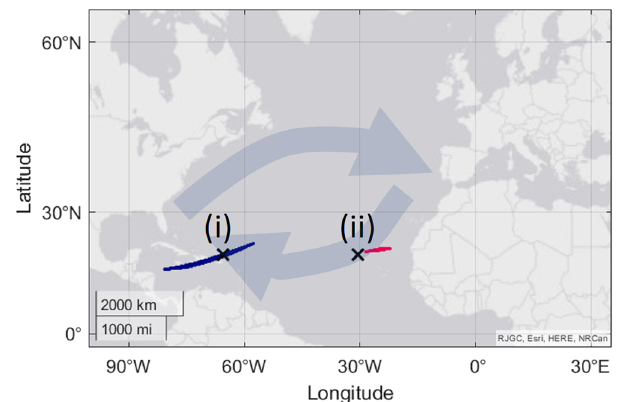
Fig. 5 Possible locations for the two virtual magnetic displacements in ref. 19 . Coloured areas show all possible locations with the same magnetic parameters as those used in the study. A different colour is used for the two virtual magnetic displacements (i and ii). The large faded arrows indicate the fl ow direction of the Atlantic